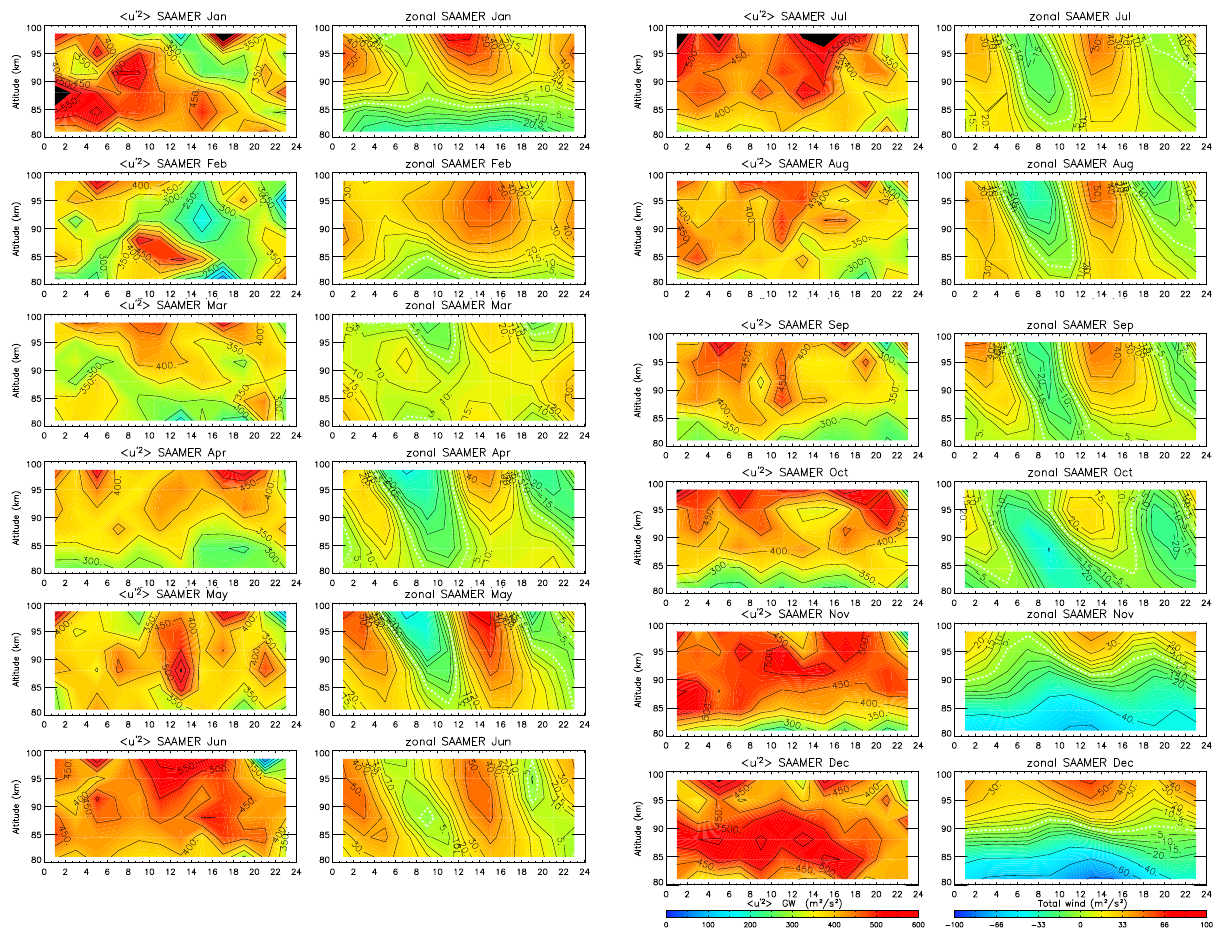
Fig. 11. The same as Fig. 9, but over Tierra Del Fuego during